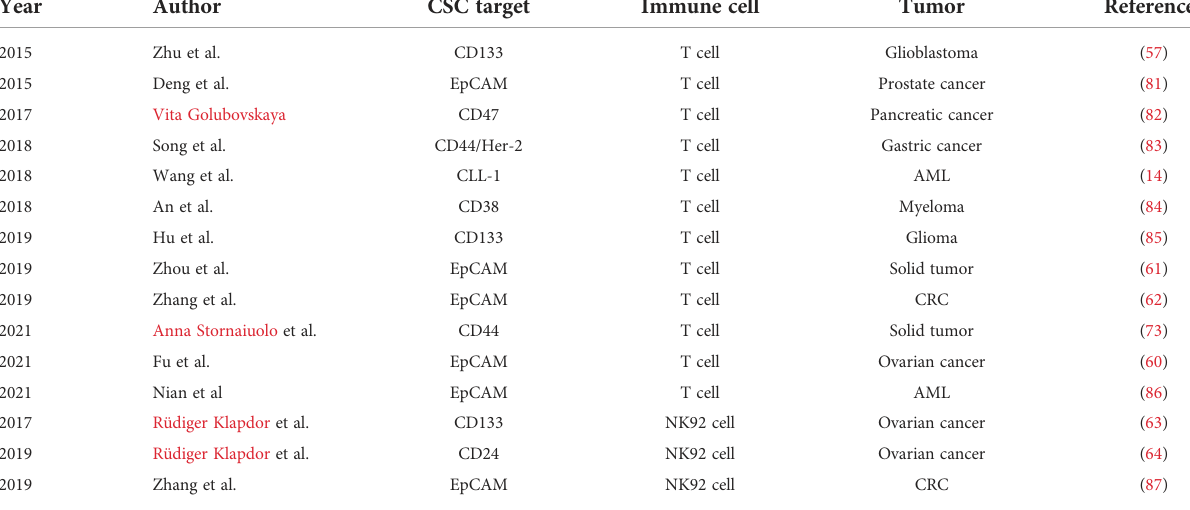
TABLE 2 Recent studies about CAR-T/NK in CSC